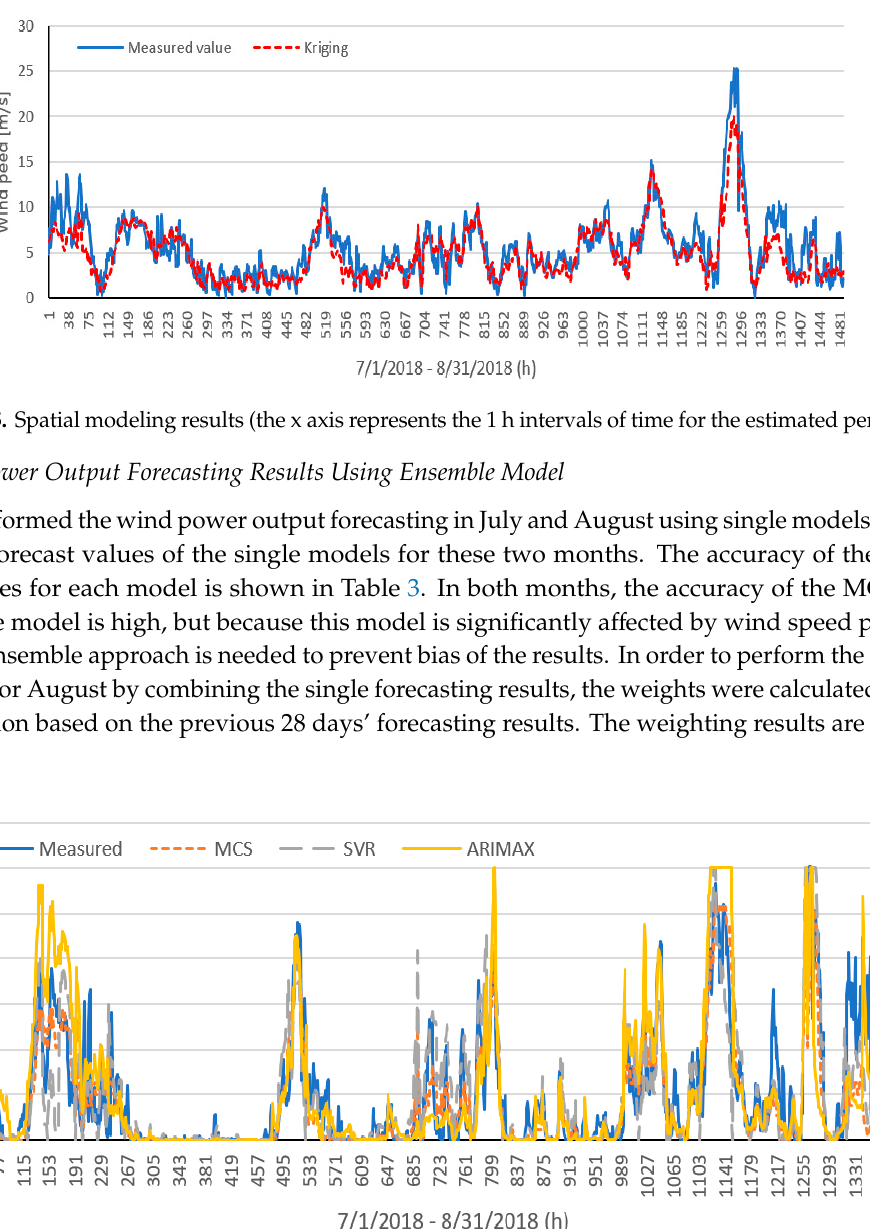
Figure 4. Training and evaluation periods for forecast.